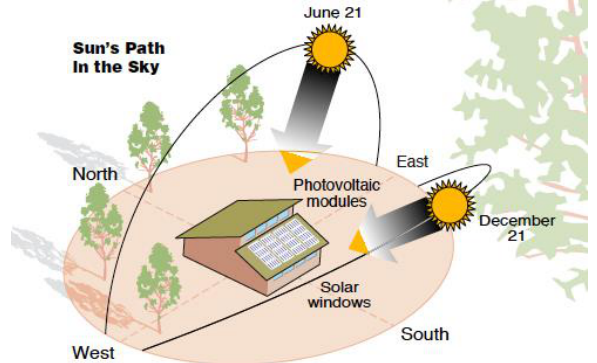
Figure 6. Illustration of the sun during winter and summer and the aspect/direction of the solar panel on a building (GPSM, 2017).